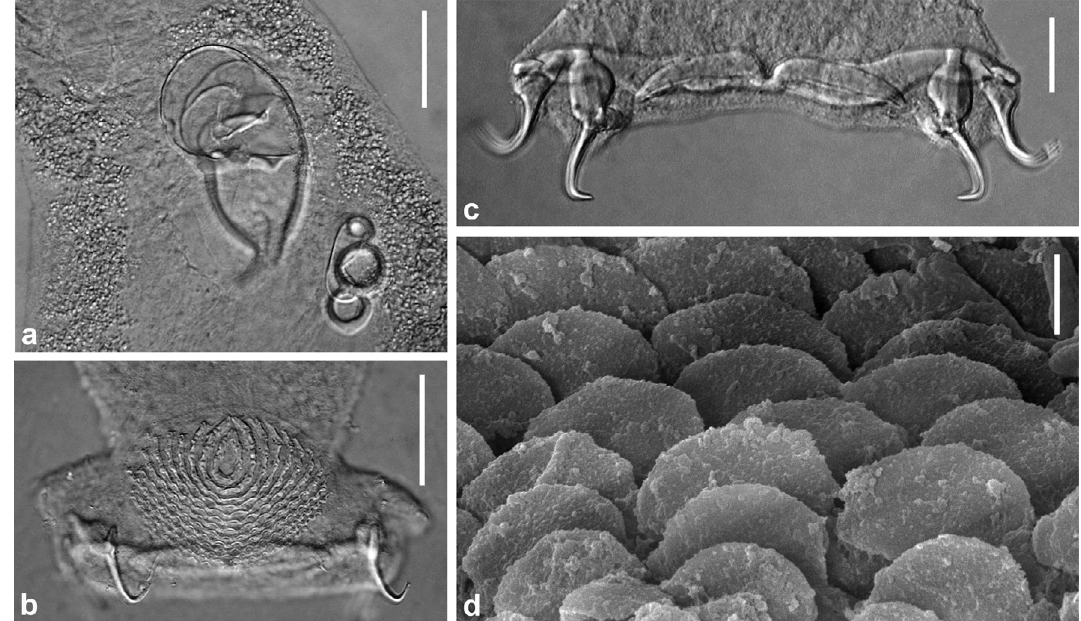
Figure 3. Pseudorhabdosynochus jeanloui n. sp. from Paranthias colonus . a–c , brightfield differential interference contrast microscope images. a , detail of quadriloculate organ and sclerotized vagina, holotype, Hoyer, ventral view. b , haptor, detail of ventral squamodisc and ventral hamuli, holotype, Hoyer, ventral view. c , haptor, detail of ventral and dorsal hamuli and bars, paratype, Hoyer, ventral view. d , scanning electron microscope image, detail of rodlet rows of a squamodisc, ventral view. Scale bars: a–b, 40 l m; c, 20 l m; d, 2 l